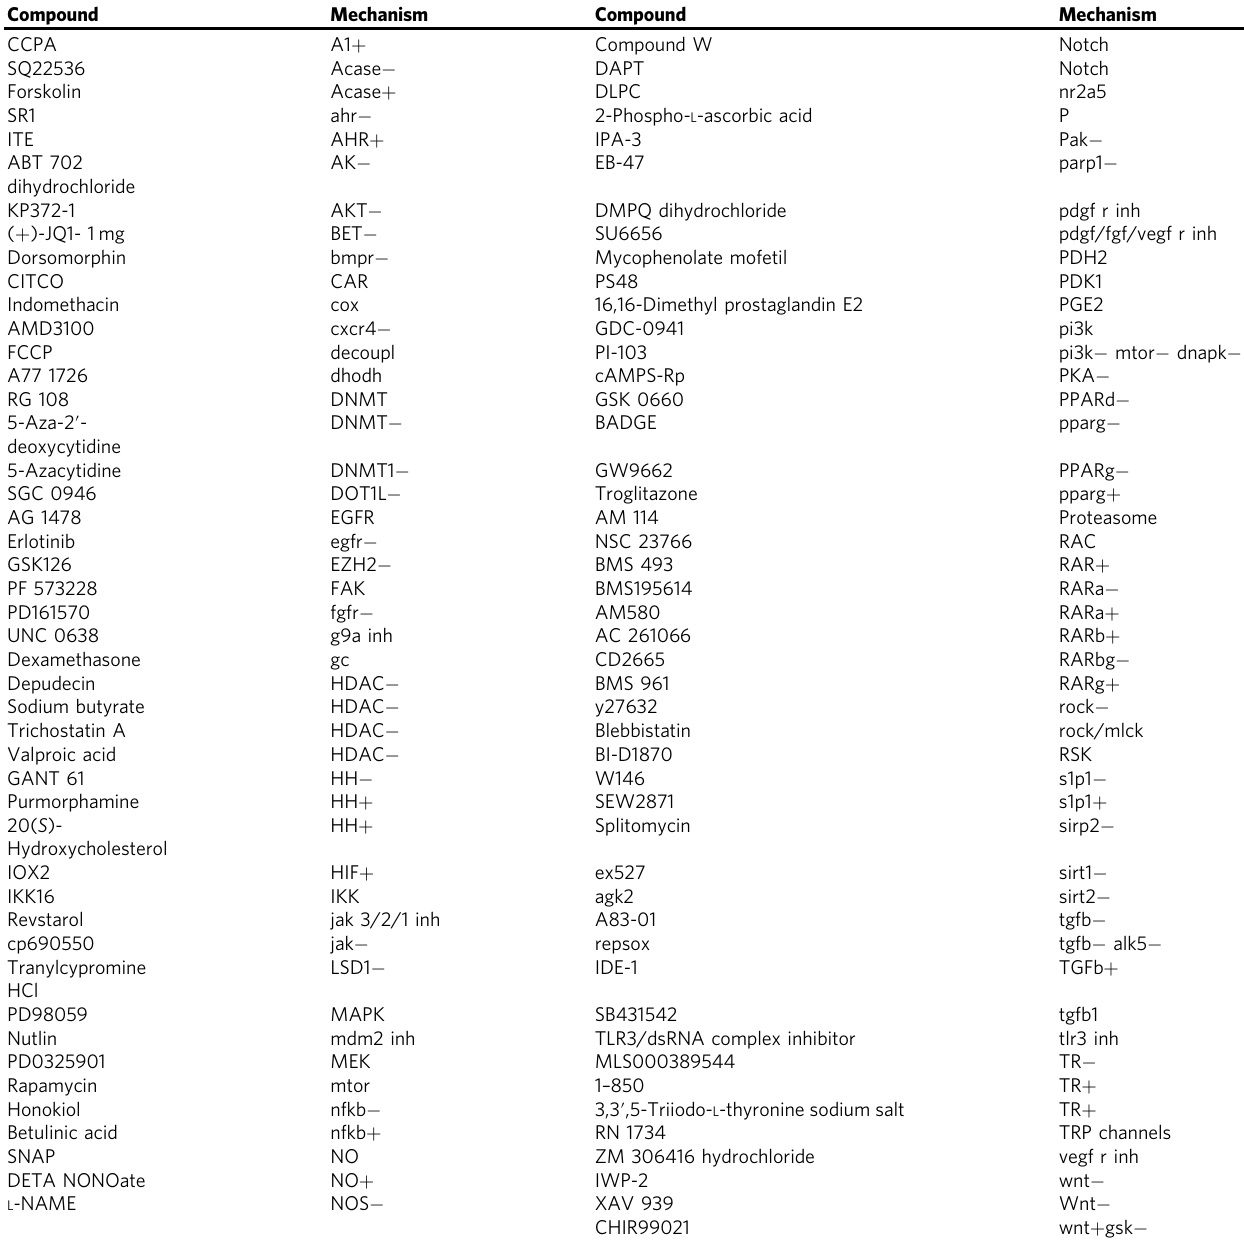
Table 1 Composition of the Stem Cell Chemical Library used for screening lung adenocarcinoma TPCs